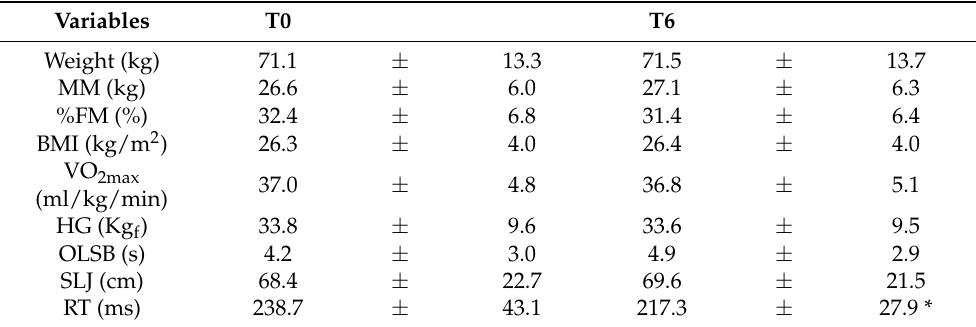
Table 1. Subjects’ body composition and physical fitness variables pre (T 0 ) and after (T 6 ) dance intervention.